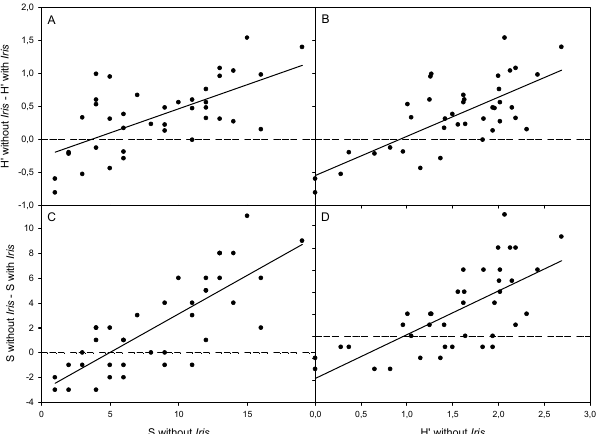
Figure 3. Relationship between the differences in α -diversity (H’) and plant species richness (S) without and with Iris pseudacorus and H’ values at study populations in the invaded San Francisco Bay-Delta Estuary. Regression equations: ( A ) y = − 0.266 + 0.073 × (R = 0.645, p < 0.0001, n = 39); ( B ) y = − 0.548 + 0.595 × (R = 0.723, p < 0.0001, n = 39); ( C ) y = − 3.074 + 0.621 × (R = 0.795, p < 0.0001, n = 39); ( D ) y = − 3.822 + 3.963 × (R = 0.702, p < 0.0001, n = 39). Distribution range, location along the estuarine gradient and the interactions be- tween range and I. pseudacorus presence, range and location, and the three-way interac- tion among range, I. pseudacorus presence and location all had a significant effects on di- versity indices (MANOVA, p < 0.05) (Table S4). According to the lineal models, α -diversity and species richness changed significantly between distribution ranges and locations. Species evenness varied significantly between I. pseudacorus presence and lo- cations. In addition, there were also a number of interactive effects of distribution range, location and invader presence that influenced diversity indices (Table S5). H’ α -diversity was 48% lower in the native than in the invaded range of I. pseudaco- rus in areas of the plant community where the invader was absent. These areas were characterized by lower species richness and evenness. In contrast, diversity and species richness within Iris -occupied plots were similar in both distribution ranges, whereas evenness was 22% higher within Iris -occupied plots in the native range than was docu- mented in the invasive range (Figure 4; Table S6). When discarding exotic species from the analysis, α -diversity within Iris -occupied plots was 24% higher in the native than in the invaded range (Figure 4; Table S7). The reported differences in diversity indices be- tween distribution ranges were reflected in lower values of the Morisita–Horn dissimi- larity index in the native vs. the invaded range when comparing un-invaded plots with themselves and with invaded plots. In contrast, higher Morisita–Horn dissimilarity in- dices were found for plots with I. pseudacorus in the native compared to the invaded range (Figure 5A, Table S8). The Sørensen dissimilarity index was always higher in the native than in the invaded range for every plot combination with and without I. pseudacorus (Figure 5B, Table S9).